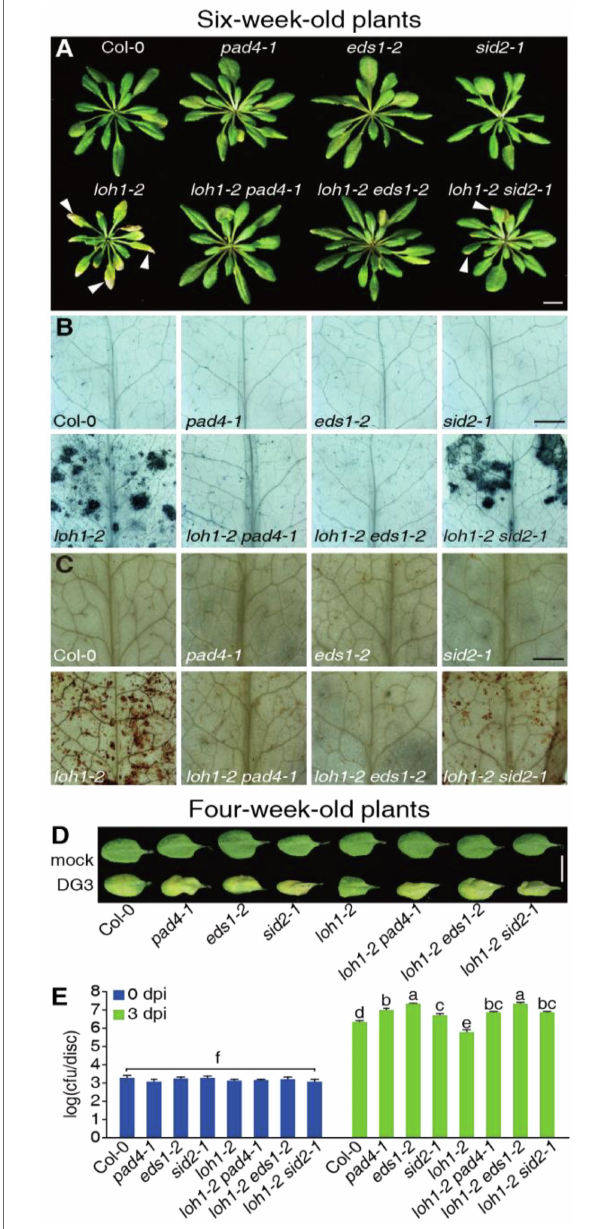
FIGURE 6 | Effect of the pad4-1 , eds1-2 , and sid2-1 mutations on the immune response and cell death caused by loh1-2 . (A) Growth phenotypes of 6-week-old plants (inflorescence stems were removed before we photographed the plants). White arrowheads indicate cell death lesions. Bar = 1 cm. (B) Trypan blue staining of leaves from (A) . Bar = 1 mm. (C) DAB staining of leaves from (A) . Bar = 1 mm. (D) The rosette leaves from 4-week- old plants were inoculated with Psm DG3, and the pictures of leaves were taken 3 days after inoculation. Bar = 1 cm. (E) Growth of Psm DG3 in leaves from (D) . Trypan blue (B) and DAB staining (C) of untreated leaves. At least 12 leaves per line were stained each time in (B,C) . At least, 30 plants per line were tested each time in (D,E) . Values are means ± SE from six biological replicates at 0 dpi and 24 biological replicates at 3 dpi in (E) . Different letters indicate significant differences assessed among all genotypes/time points, as determined by Fisher’s protected least significant difference (PLSD; p < 0.05) in (E) . The experiments were conducted three times using independent